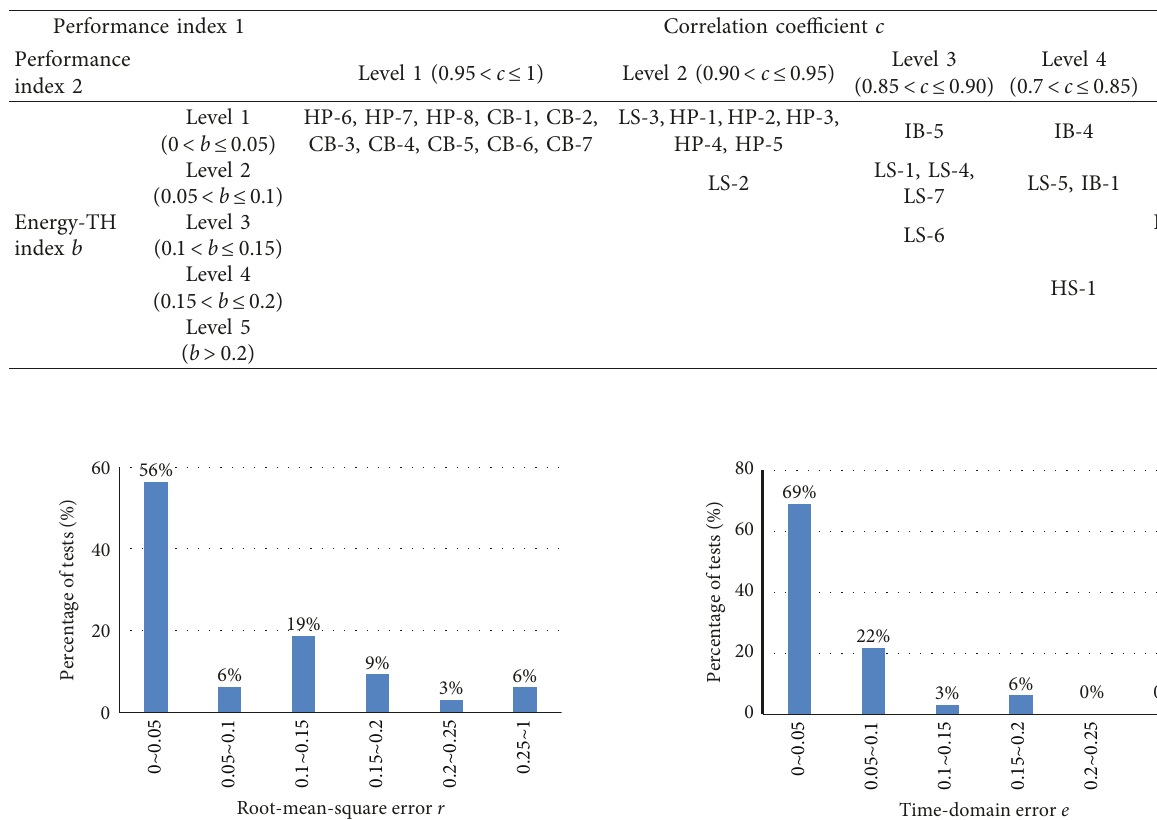
Table 8: Double parameter performance table for accuracy assessment of shake table devices.